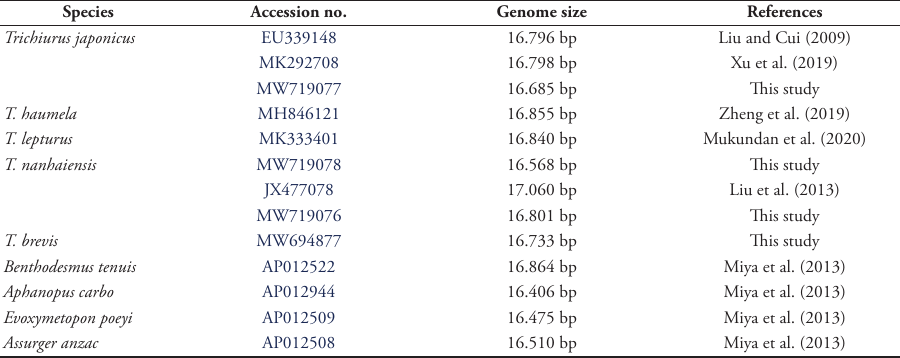
Table 1. Information on the mitogenomes used in this study. Species Accession